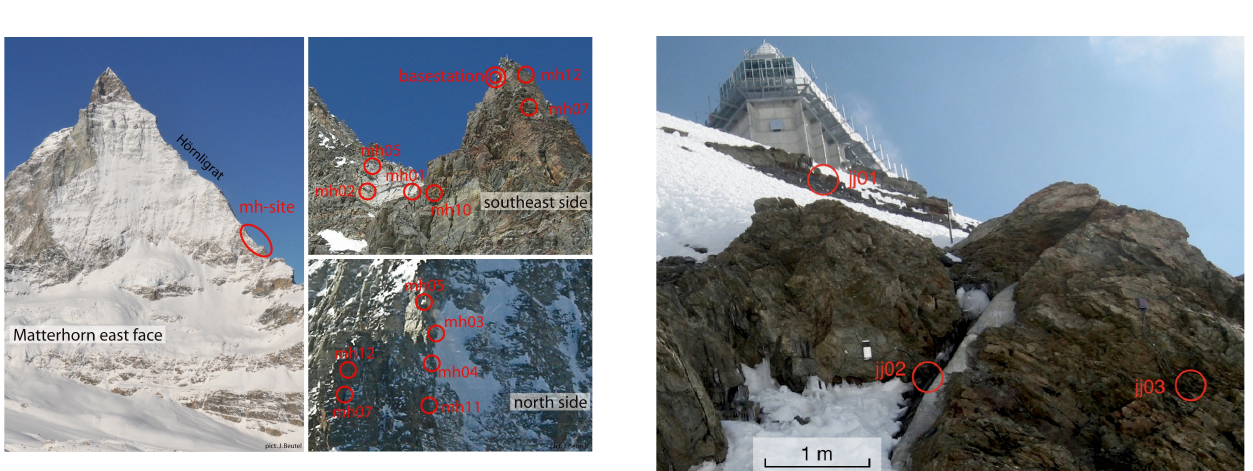
Fig. 1. Location of the two field sites. The base map shows the potential permafrost distribution in the western Swiss Alps (FOEN 2006).